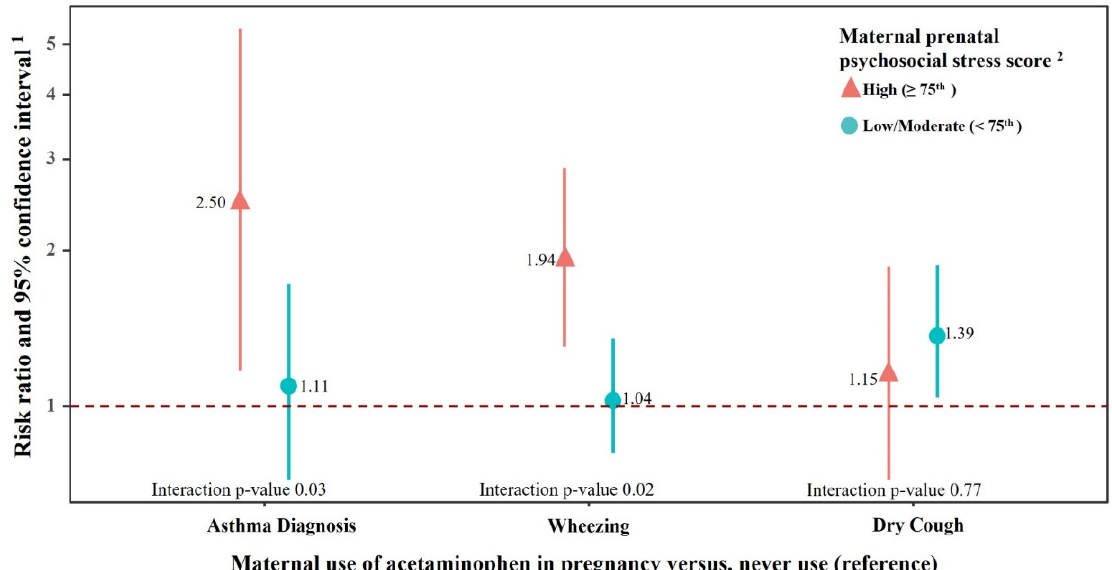
Figure 1. Risk ratio (RR) and 95% confidence interval (CI) for asthmatic outcomes in early childhood according to maternal prenatal acetaminophen use, stratified by maternal psychosocial stress during pregnancy. 1 RR was adjusted for maternal age, parity, maternal race/ethnicity, household income, smoking, maternal high fever, and aspirin or ibuprofen during pregnancy. Among women reporting high prenatal stress, 104 reported prenatal acetaminophen use, and 29, 78, and 67 children had an asthma diagnosis, wheezing and dry cough, respectively. Among women reporting low prenatal stress, 289 reported prenatal acetaminophen use, and 89, 226, and 176 children had an asthma diagnosis, wheezing and dry cough, respectively. 2 A maternal pregnancy stress index was generated from a validated questionnaire that assessed measures of pregnancy anxiety, chronic stress, acute stress due to negative life events, and lack of paternal support.